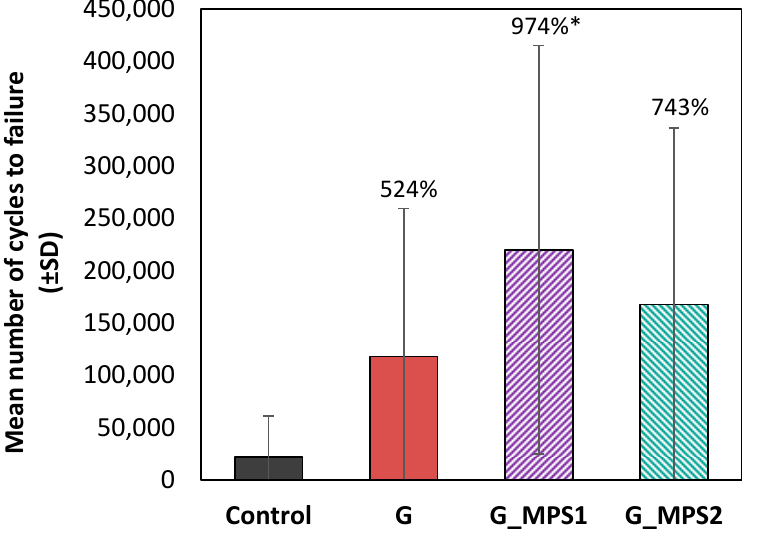
Figure 3. Mean number of cycles to failure ( ± SD) for the Control and the cements with 0.1 wt.% of G, G_MPS1 and G_MPS2. The difference of each value compared with control is given in % and significant differences ( p < 0.05) are indicated with *.